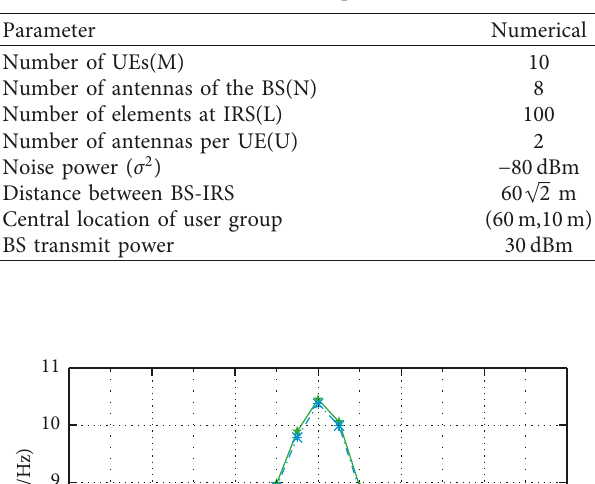
Table 1: Simulation parameters.